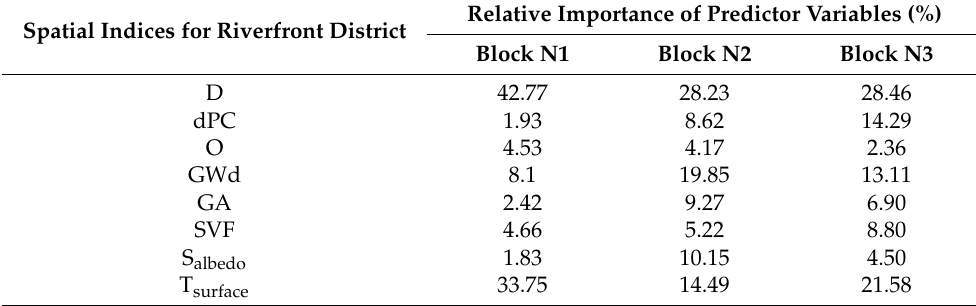
Table 4. Relative importance of the green corridor indices for each simulation model. Relative Importance of Predictor Variables Spatial Indices for Riverfront District